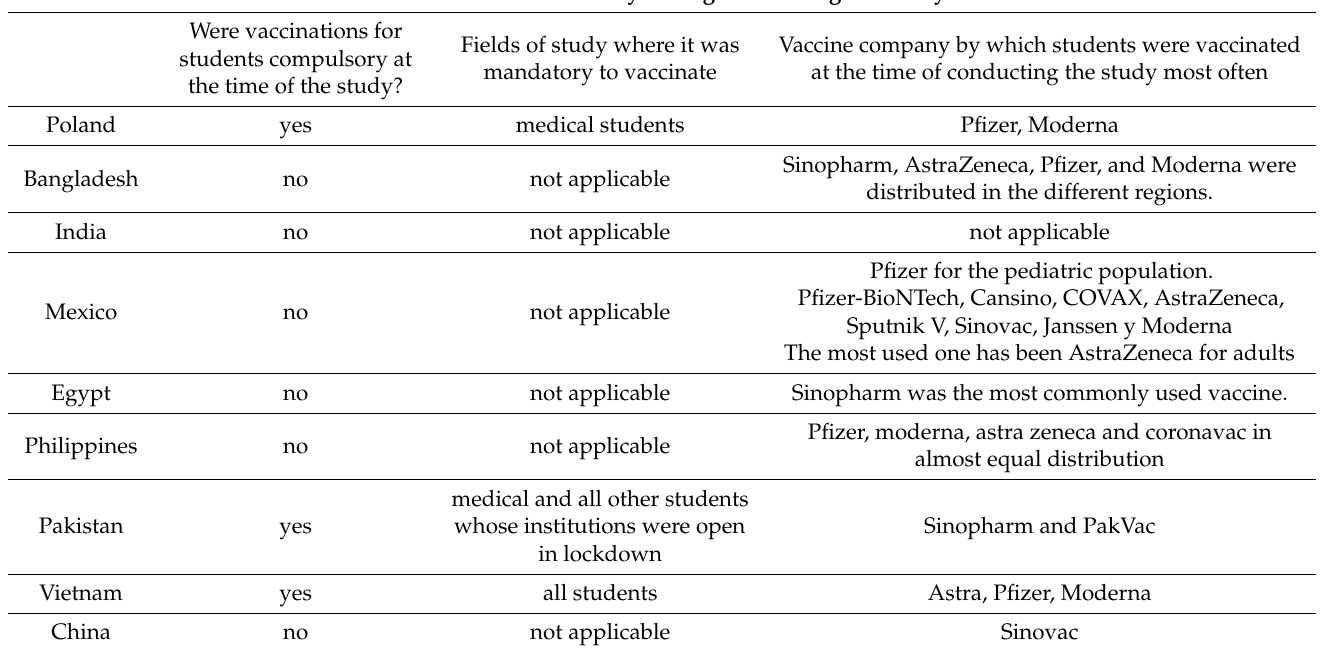
Table 2. Information on whether vaccines were mandatory, for which students, and the most common vaccine companies used in a particular country at the time of conducting the